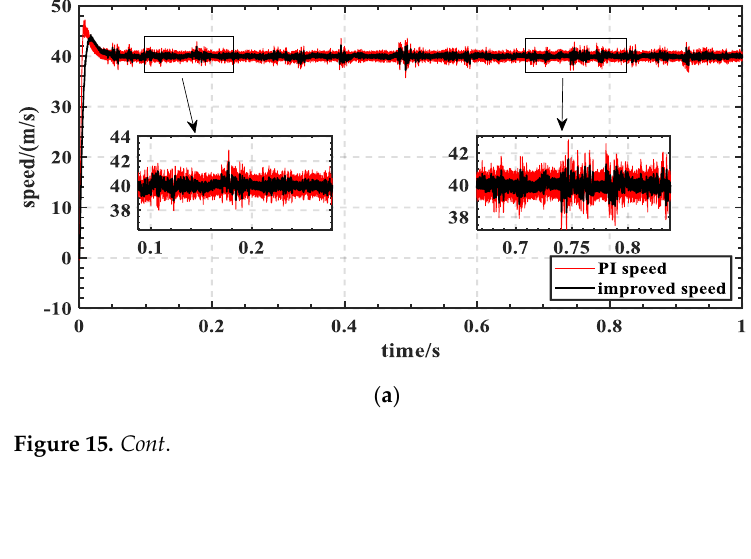
Figure 14. The experiment platform.